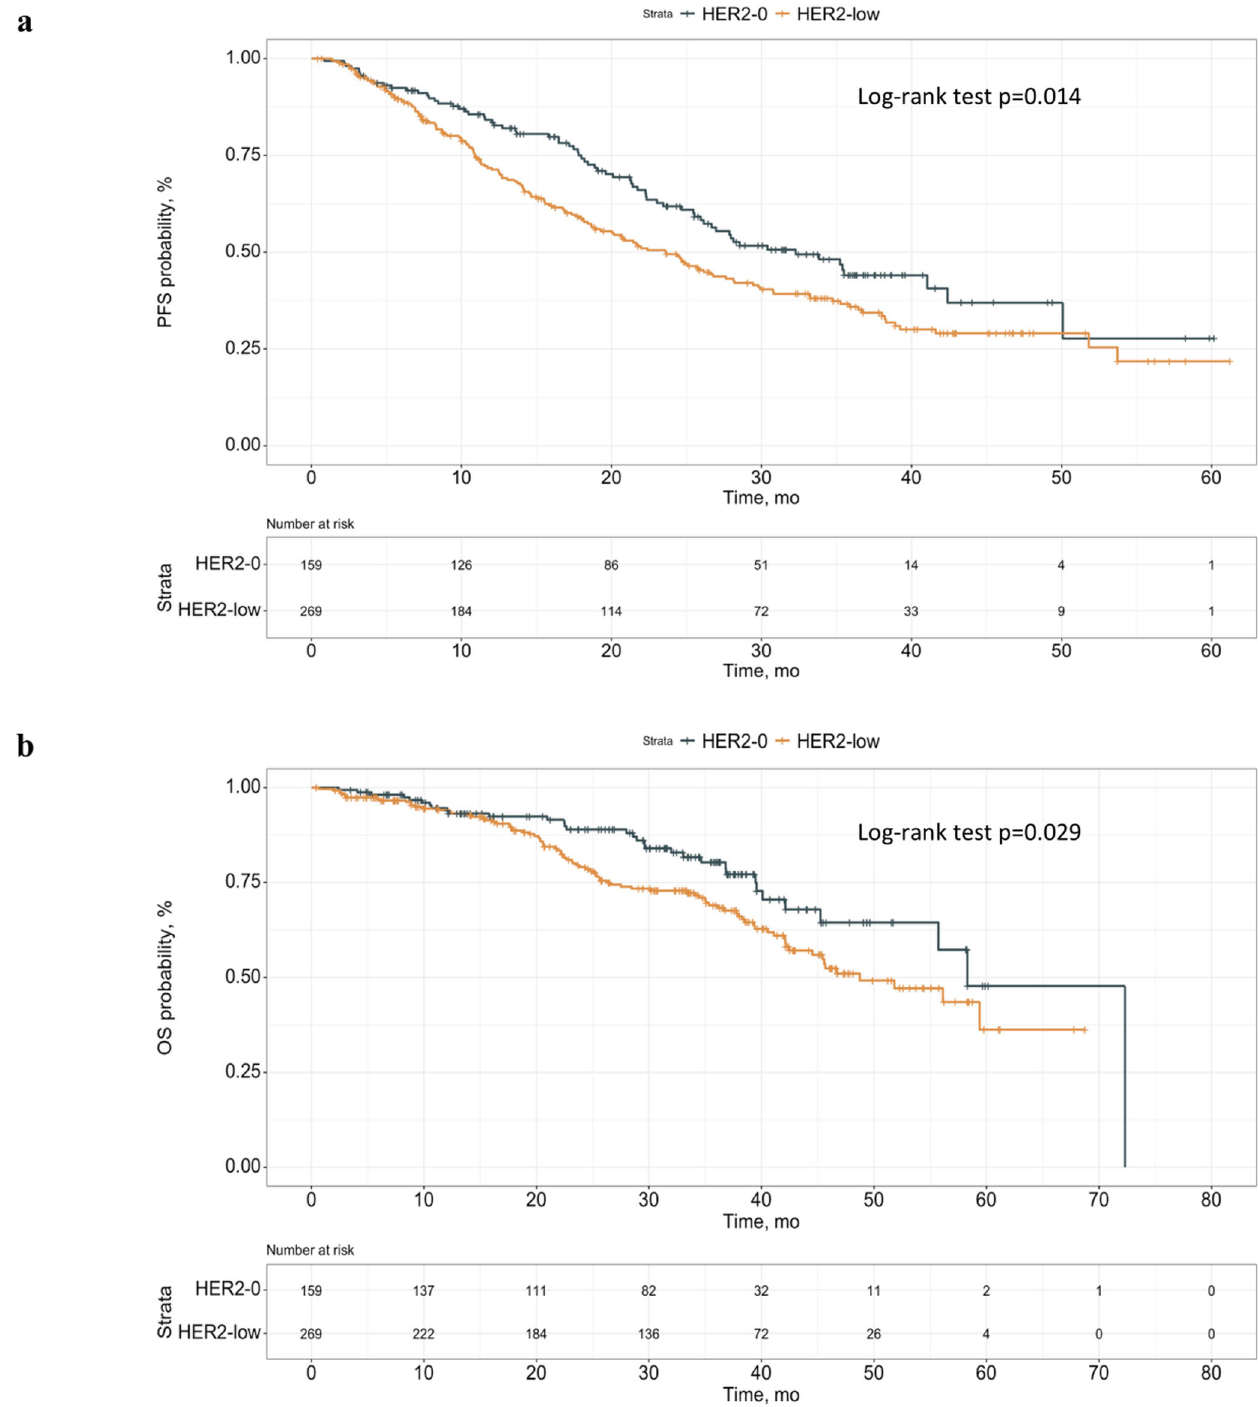
Fig. 1 Kaplan – Meier analysis of progression-free survival (a) and overall survival (b) in the HER2-low cohort and HER2-0 cohort. a Median Progression-free Survival (PFS) was 23.6 months (95% CI,18.9-28.1) in the HER2-low cohort and 32.3 months (95% CI, 26.1-NA) in the HER2-0 cohort. b Median Overall Survival (OS) was 48.7 months (95% CI, 42.5-NA) in the HER2-low cohort and 58.3 months (95% CI, 55.7-NA) in the HER2-0 cohort. HER2 human epidermal growth factor receptor 2, CI con fi dence intervals, PFS progression free metastases and type of ET) con fi rmed an independent and worse PFS when compared to patients with HER2-0 BC (median PFS statistically signi fi cant association between HER2-low status and [range]: 23.6 months [18.9 – 28.1] vs. 32.3 months [26.1-NA]; p = 0.014) worse PFS (adjusted hazard ratio [aHR] 1.42; 95% con fi dence interval (Fig. 1). Multivariable analysis adjusting the impact of HER2 status on [CI]:1.07 – 1.89; p = 0.0163) (Table 1). Other covariates associated with PFS for clinically relevant covariates (age, ER α expression, Ki-67 an increased risk of disease progression were: worse ECOG PS and expression, number of metastatic sites, disease-free interval [DFI], de the presence of liver metastases. On the other hand, higher ER α novo metastatic disease, ECOG performance status [PS], liver